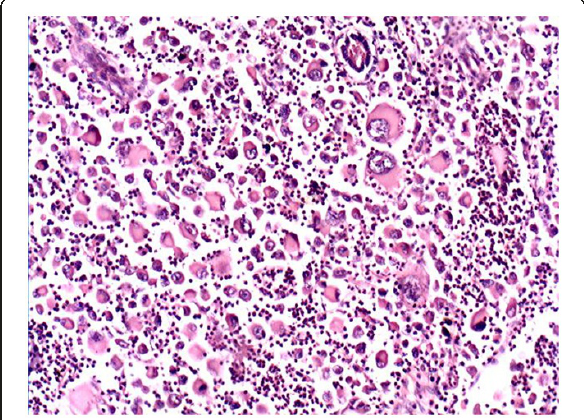
Figure 2 Hematoxylin-eosin staining of LCS (200×).